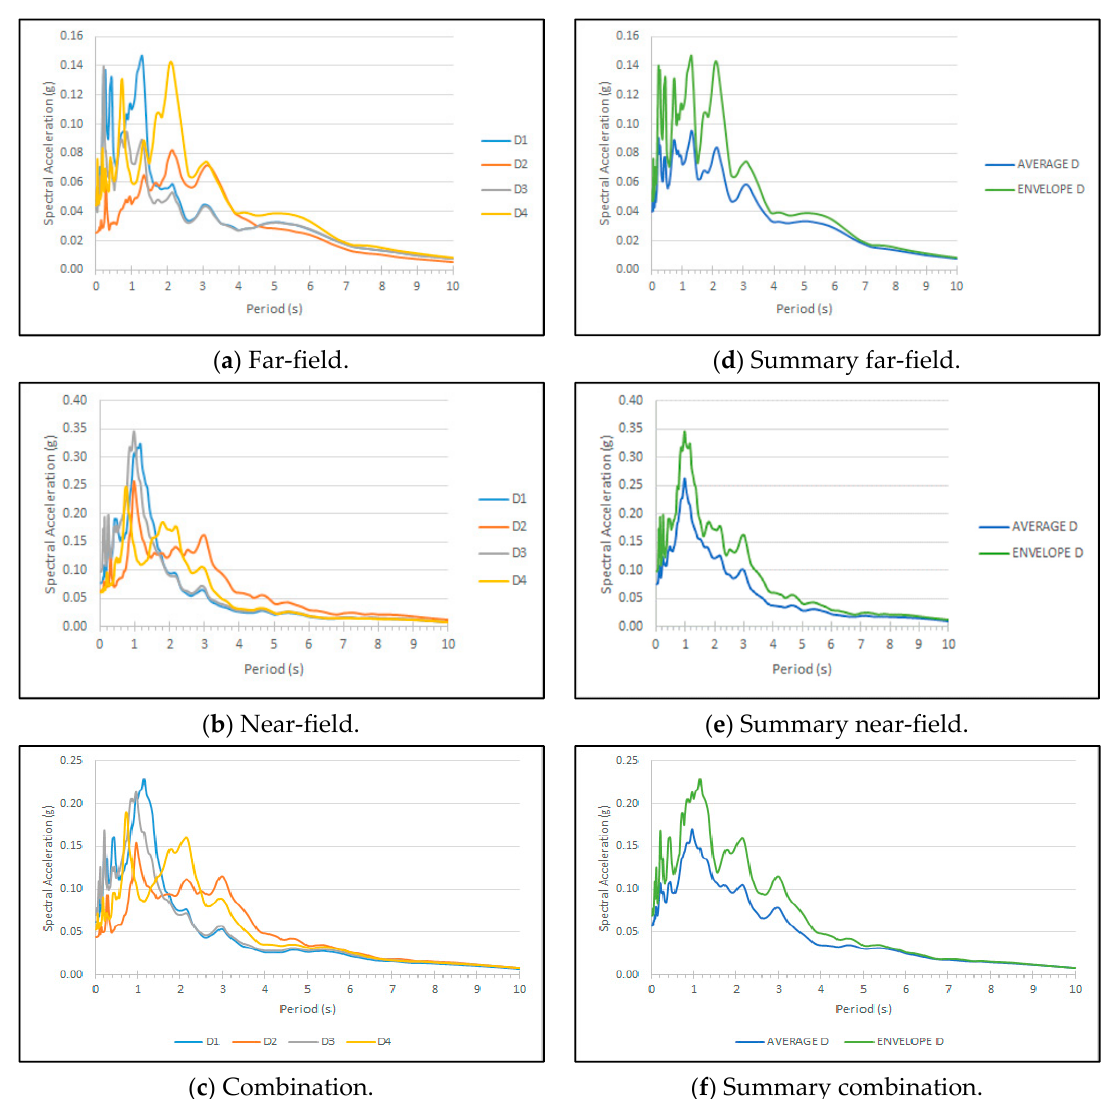
Figure 13. Average spectral acceleration for soil type D.